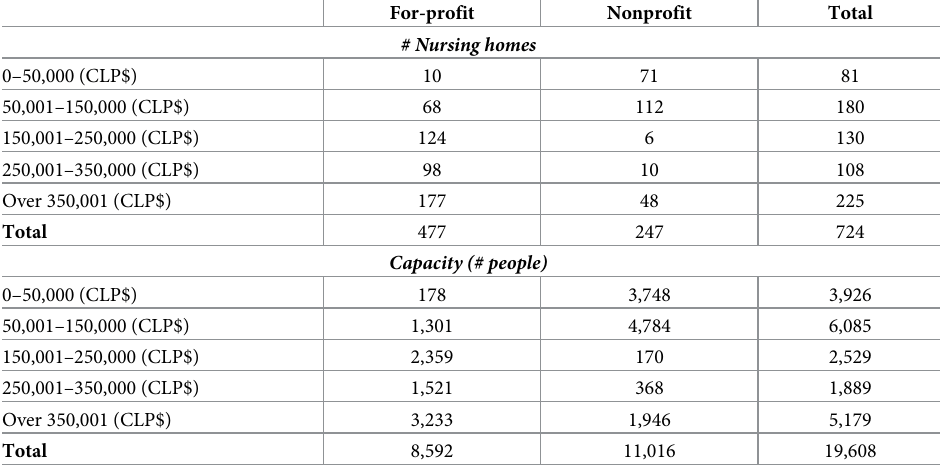
Table 1. Distribution of nursing homes and number of people in NH by price and ownership (Chilean pesos, CLP $ 2010). For-profit Nonprofit Total # Nursing